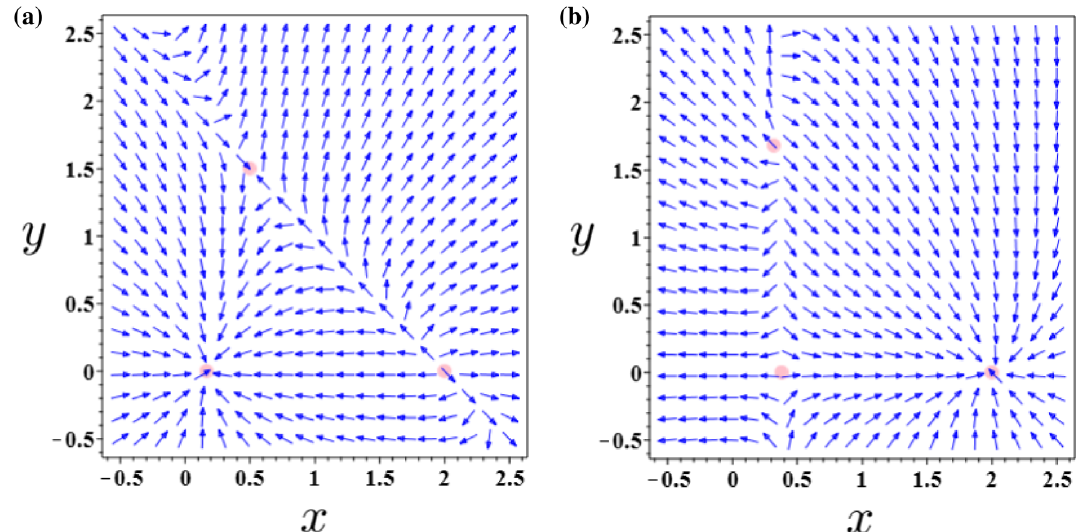
Fig. 1 This figure illustrates two different phase-portraits of the sys- tem (10)–(11). Plot ‘ a ’ indicates the phase diagram when the values of the constant parameters are selected as: κ 2 = 1, w 0 = + 1, w 1 = − 1, and α = + 1 (i.e. the chosen values belong to ‘Set-1’ and ‘Set-3’), while